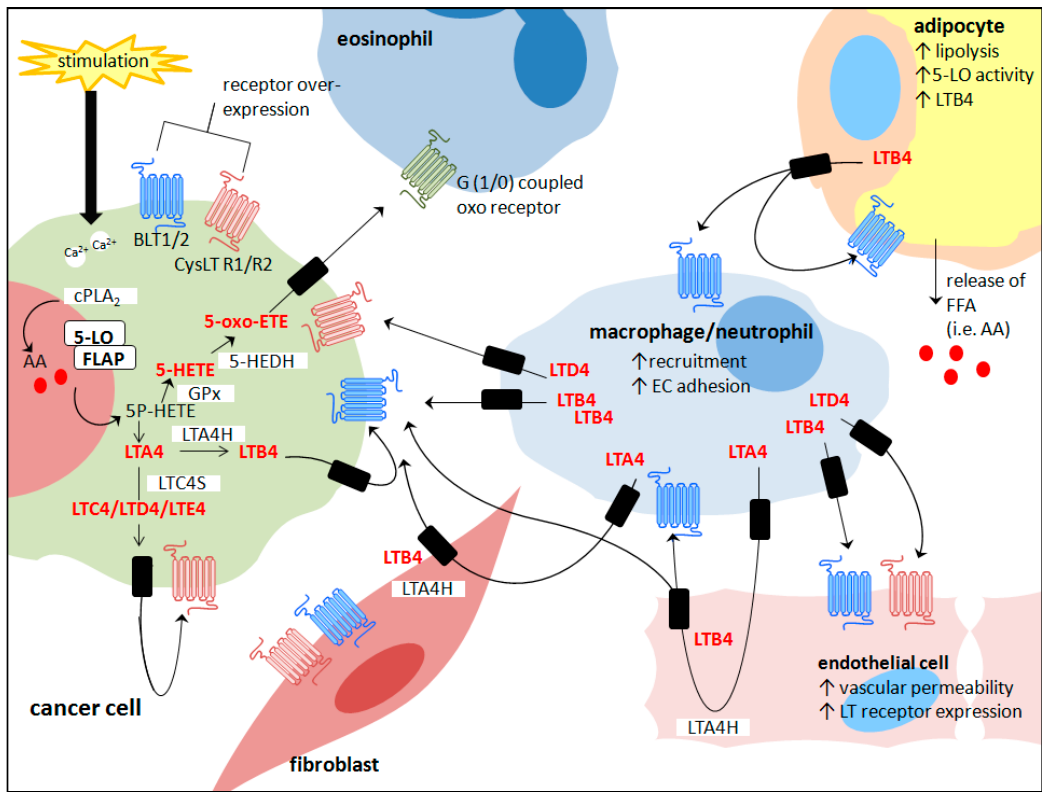
Figure 2. Summary of cross-talk between cancer cells and the tumour microenvironment mediated through the 5-lipoxygenase pathway.